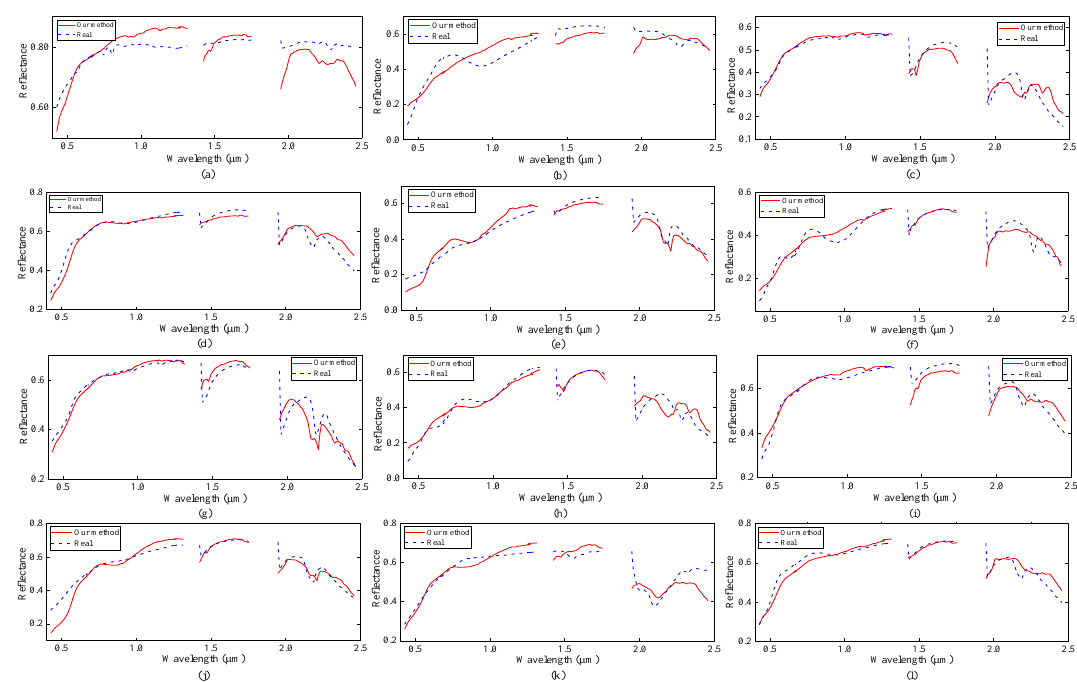
Figure 7. Endmember signatures in the USGS library and the endmember estimates obtained by our MDA-MVSA method from the Cuprite subimage. The corresponding signatures are the following. ( a ) Chlorapatite WS423; ( b ) Jarosite WS368 Pb; ( c ) Montmorillonite SCa-2.a; ( d ) Kaolin/Smect KLF511 12%K #1; ( e ) Kaolin/Smect KLF508 85%K; ( f ) Nontronite NG-1.a; ( g ) Montmorillonite SCa-2.b; ( h ) Nontronite SWa-1.a; ( i ) Kaolin/Smect KLF511 12%K #2; ( j ) Kaolin/Smect H89-FR-5 30K; ( k ) Buddingtonite GDS85 D-206; and, ( l ) Kaolin/Smect KLF511 12%K #3.